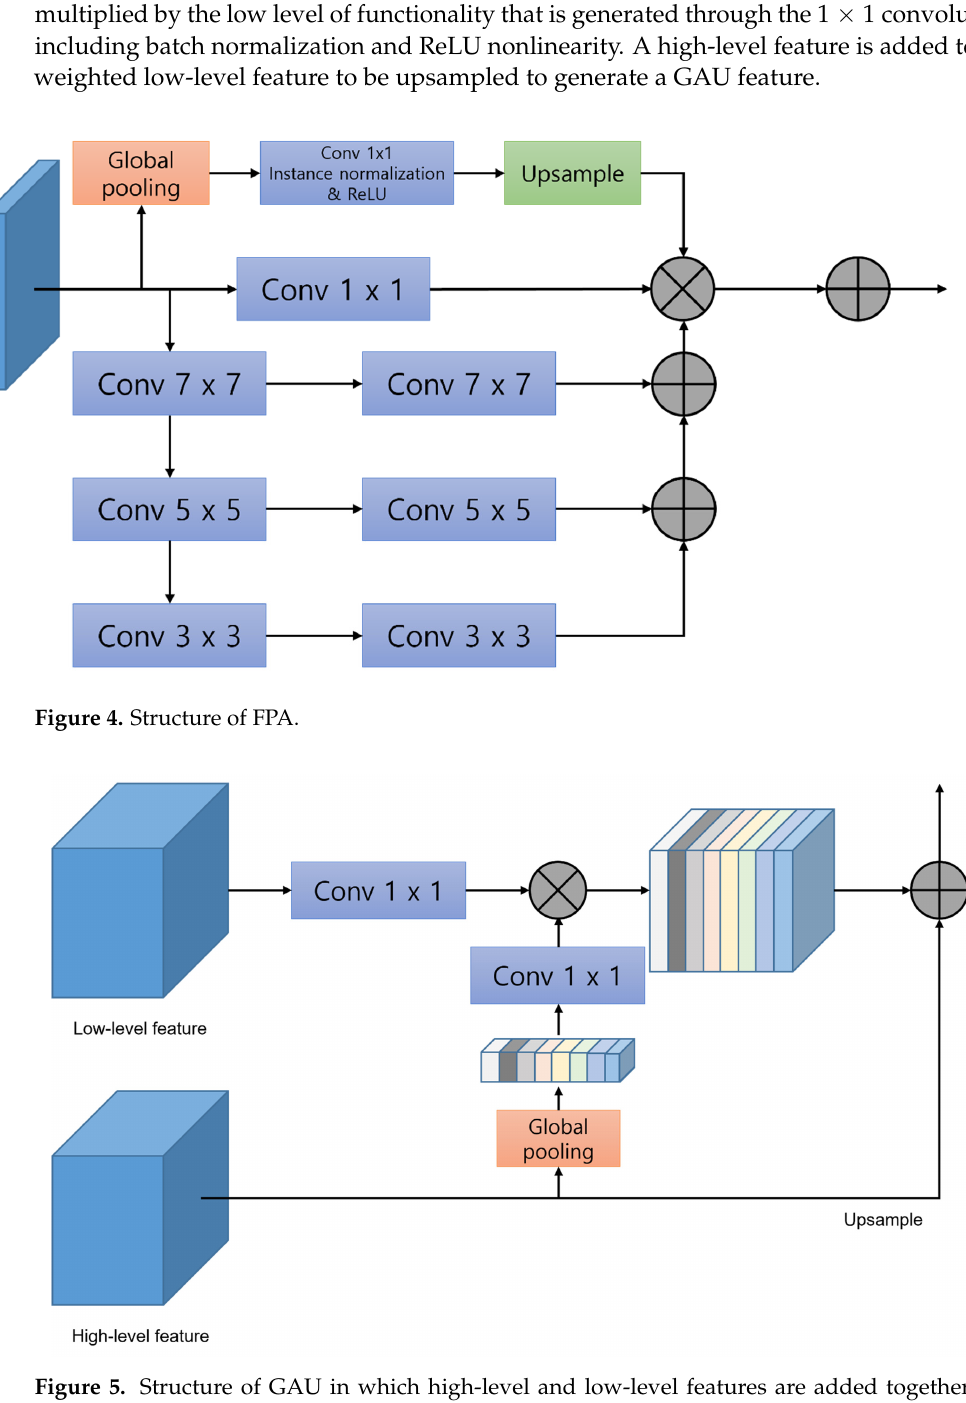
Figure 5. Structure of GAU in which high-level and low-level features are added together and up- sampled to create features.